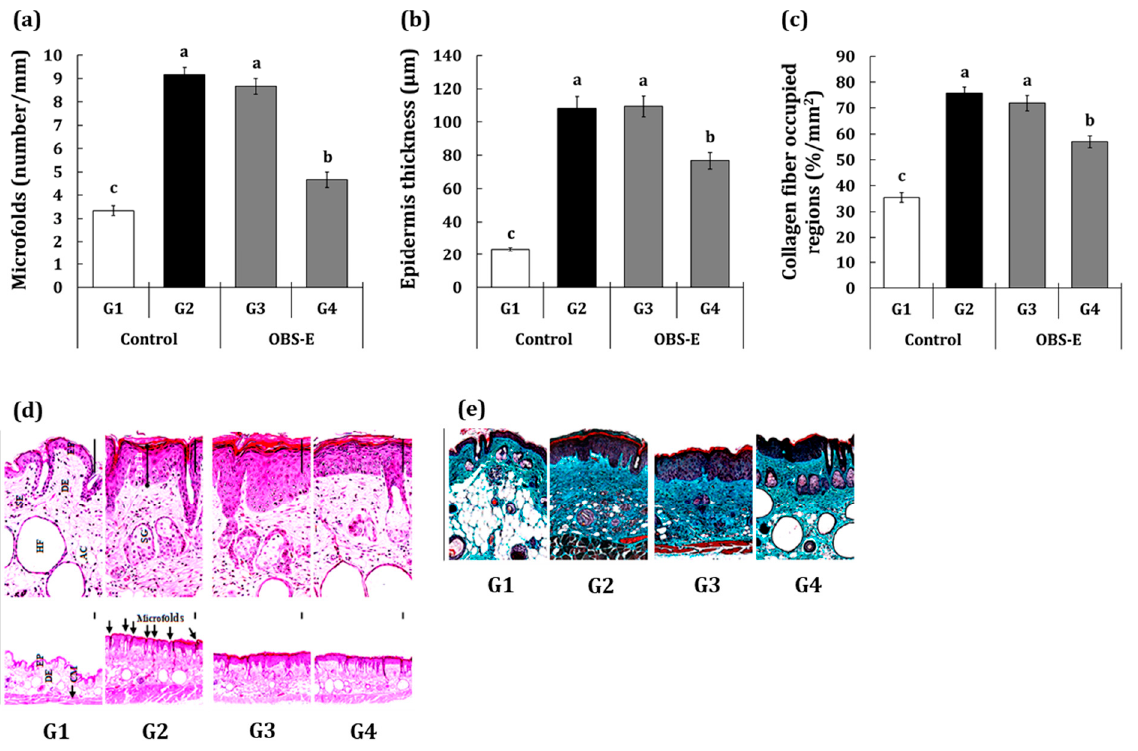
Figure 5. Effect of oral administration of OBS-E on ( a ) number of microfolds, ( b ) epidermis thickness, and ( c ) collagen fiber-occupied regions. ( d ) Skin biopsy samples stained with H&E for analyzing the microfold number and epidermal thickness, ( e ) Skin biopsy samples stained with Masson’s Trichrome stain for analyzing the collagen fiber-occupied region. AC, adipocyte; CM, cutaneous muscle; DE, dermis; EP, epidermis; EpTh, epidermal thickness measured; HF, hair follicle; SC, sebaceous gland; Scale bars = 80 µ m. G1, non-irradiated control group administered saline; G2, UVB-irradiated control group administered saline; G3 and G4, UVB-irradiated test agent groups administered OBS-E at doses of 50 and 200 mg/kg BW/day, respectively. Different superscripts indicate significant difference among groups by Duncan’s multiple range test ( p < 0.05).